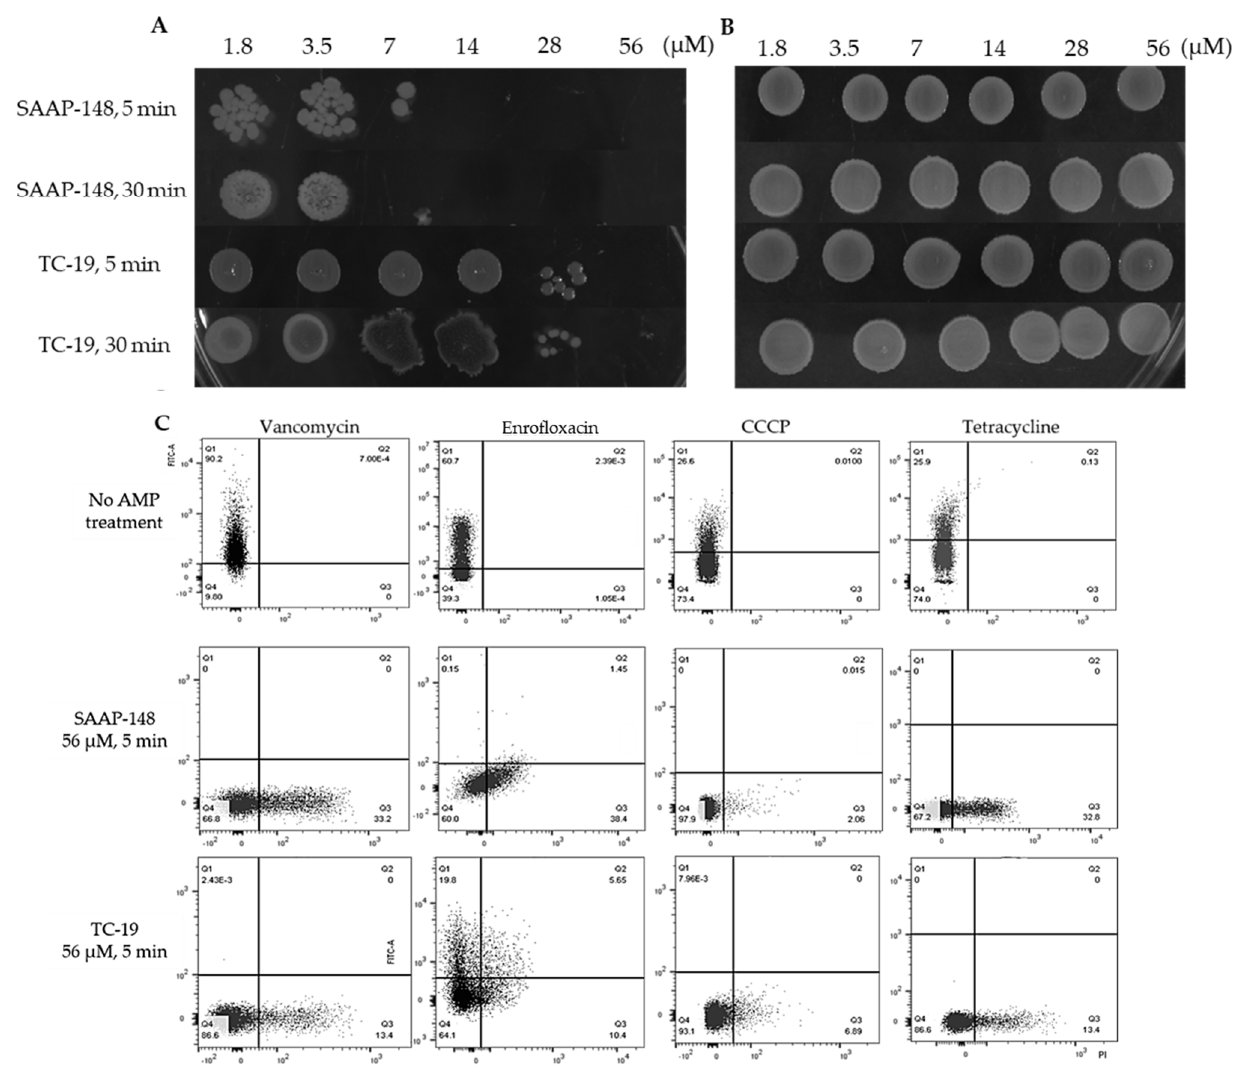
Figure 7. Tested cationic antimicrobial peptides SAAP-148 and TC-19 rapidly killed Bacillus subtilis vegetative cells ( A ) and persisters ( C ) with different efficiency, but not dormant spores ( B ). The drop plate method indicated that: ( A ) 14 uM SAAP-148 and 56 uM TC-19 could kill B. subtilis vegetative cells within 5 min and elongated exposure time didn’t cause a significant change; ( B ) B. Subtilis dormant spores were not sensitive to SAAP-148 and TC-19. To analyze the efficacy of 56 uM SAAP-148 and TC-19 against persisters, 5(6)-CFDA and PI staining was used to indicate the viability and permeability of persisters. Flow cytometry results ( C ) showed that AMPs exposure killed most persisters within 5 min and enrofloxacin- triggered persisters showed higher tolerance to tested AMPs, especially to TC-19. Note that Figure 2C was used in this figure as flow cytometry patterns of bacteria after antimicrobial exposure without AMPs treatment. X and Y axes show the intensity of 5(6)-CFDA and PI, respectively.